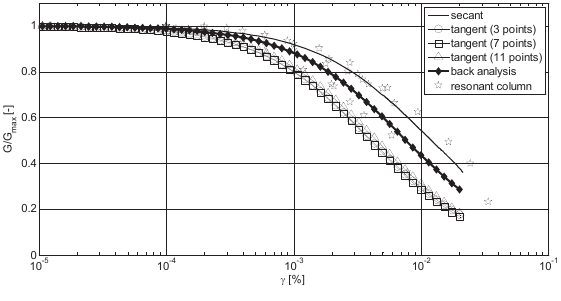
Fig. 15. The results of RC/TS analyses of the sample S3935. Figure 15: The results of RC/TS analyses of the sample